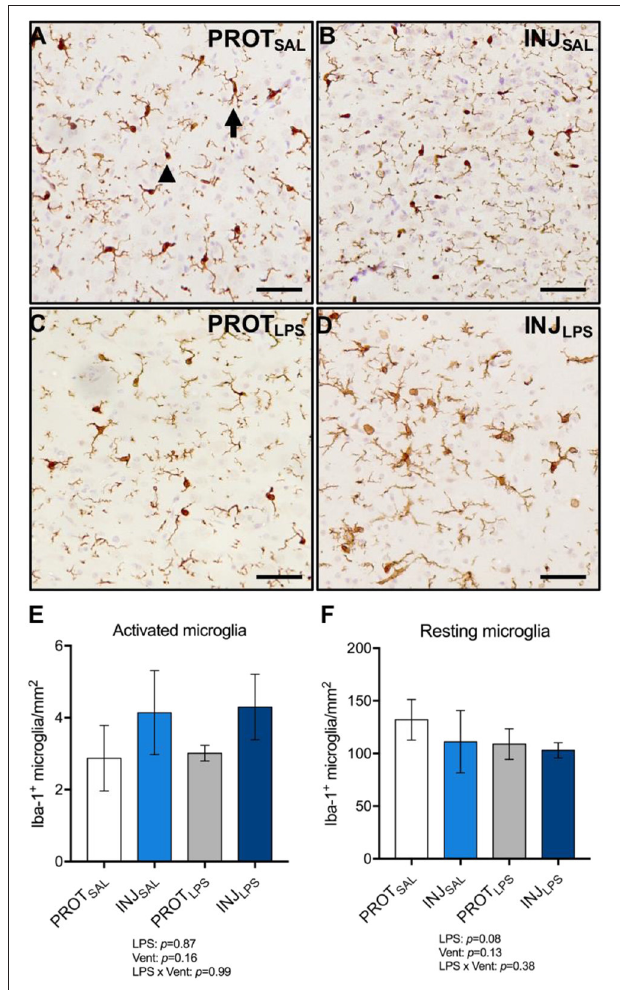
FIGURE 5 | LPS exposure, irrespective of ventilation strategy, does not change the number of activated or resting microglia in the cortical gray matter. Representative images of Iba-1 + microglia in the gray matter (A–D) . LPS exposure did not significantly change the number of activated (amoeboid; arrowhead) microglia (E) , or resting (ramified; arrow) microglia (F) . Magnification = 2x, scale bar = 20 µ m. PROT SAL , N = 5; PROT LPS , N = 6; INJ SAL , N = 6; and INJ LPS , N =